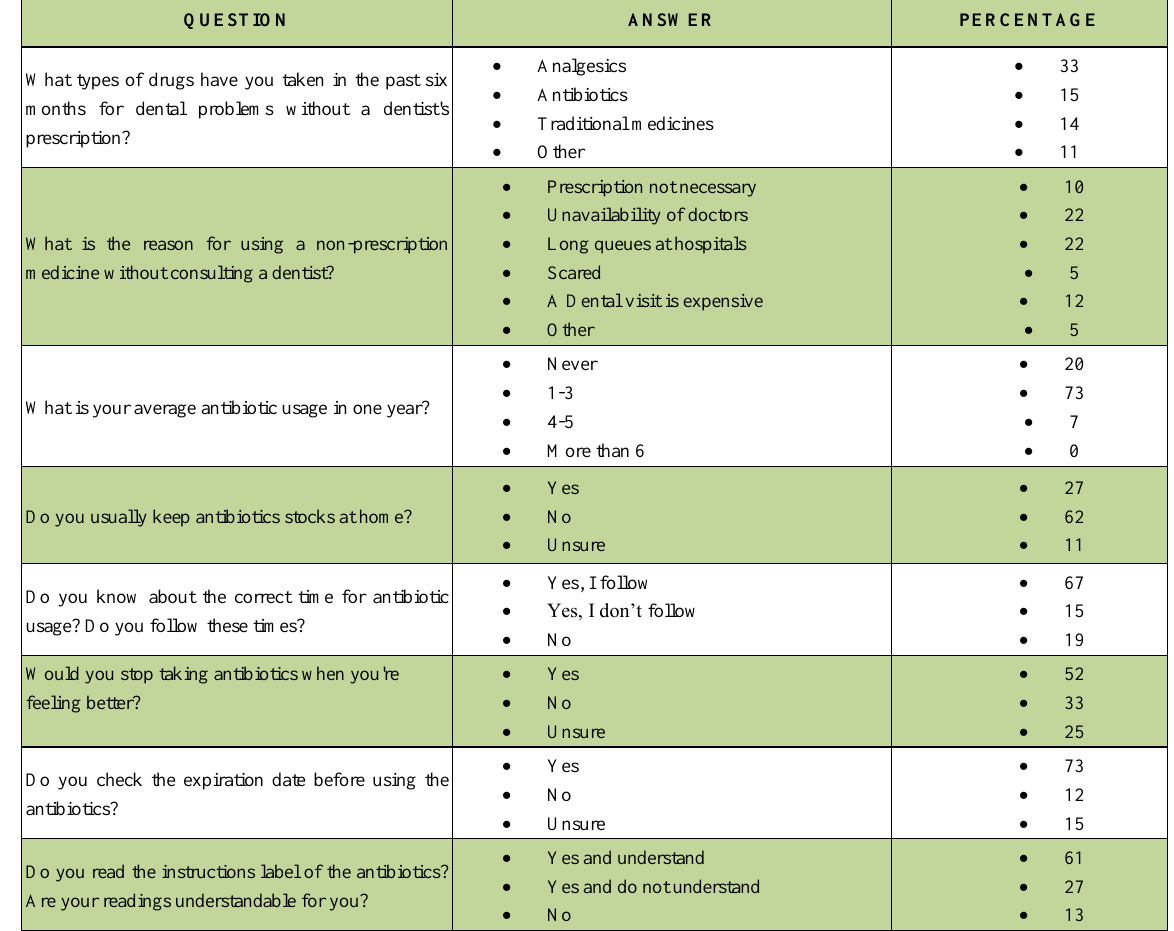
Table 1. Medication use attitudes of